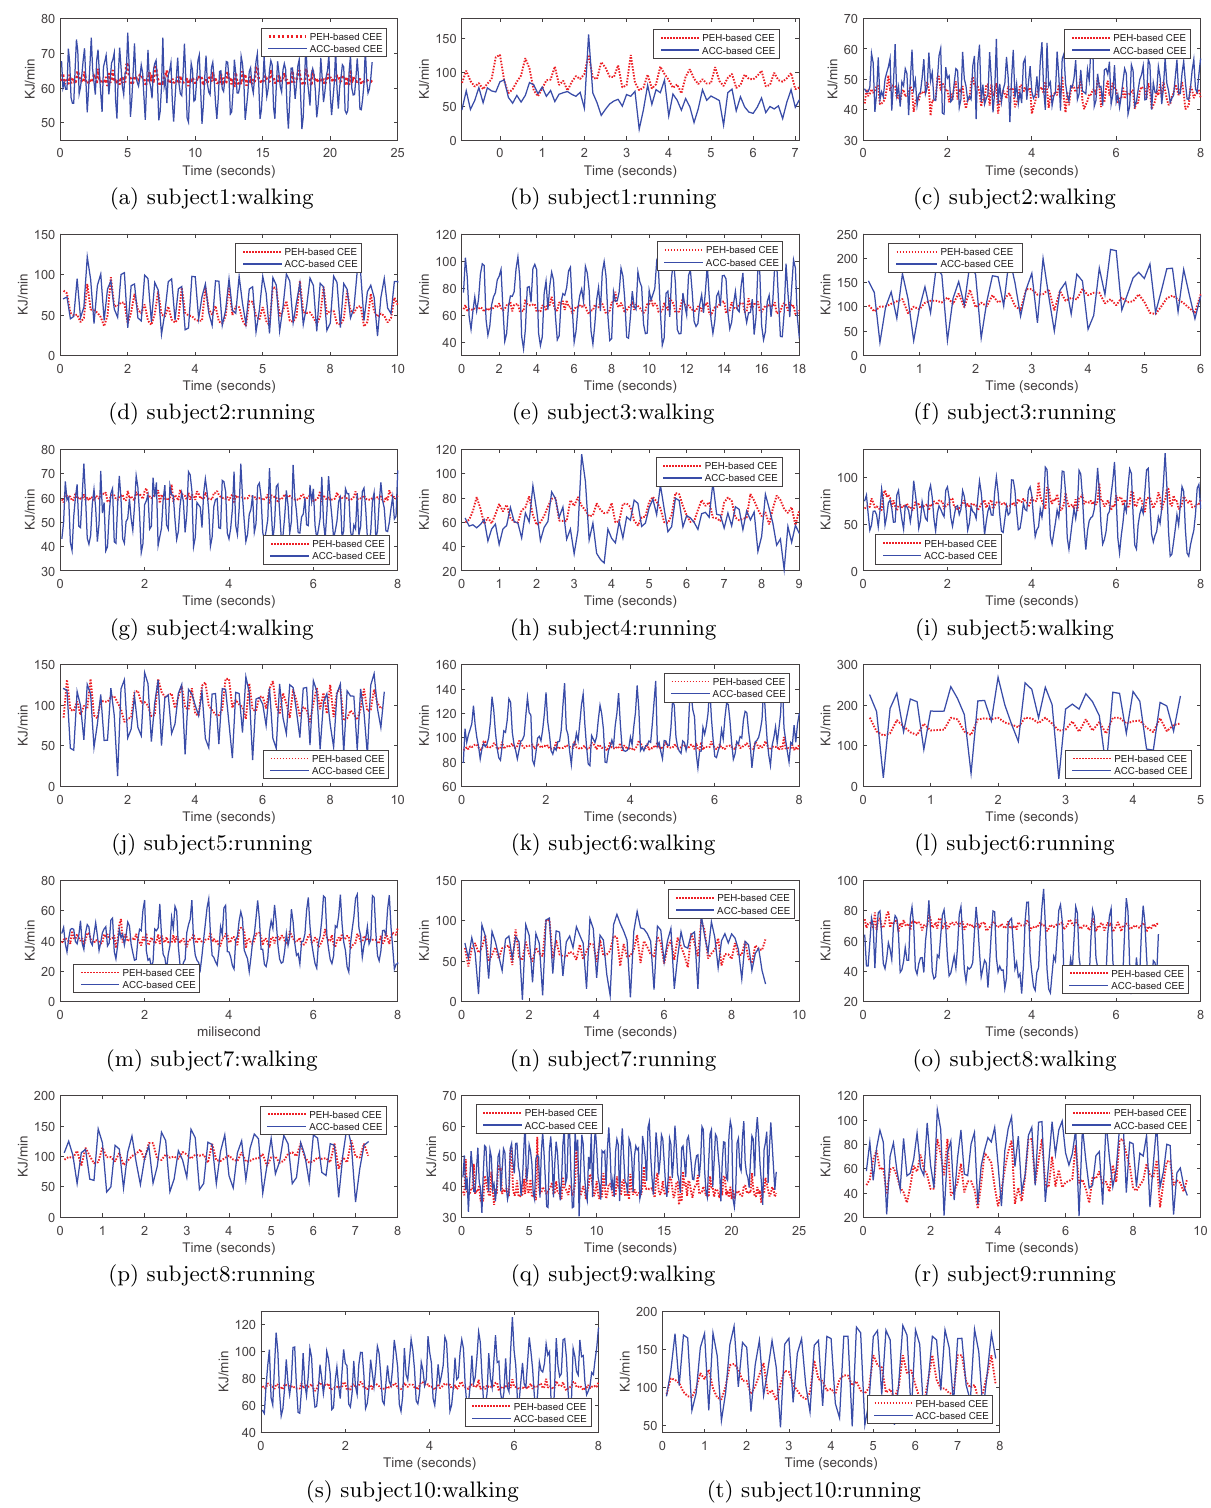
Figure 8: The instantaneous estimation results of the PEH-based and ACC-based CEE for all the ten subjects, for both walking and